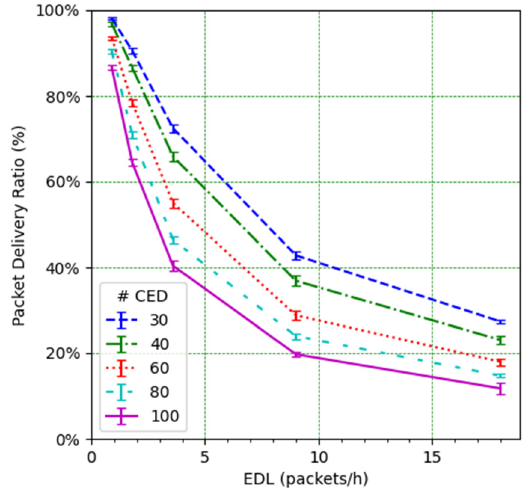
Figure 11. PDR for CEDs vs. EDL.